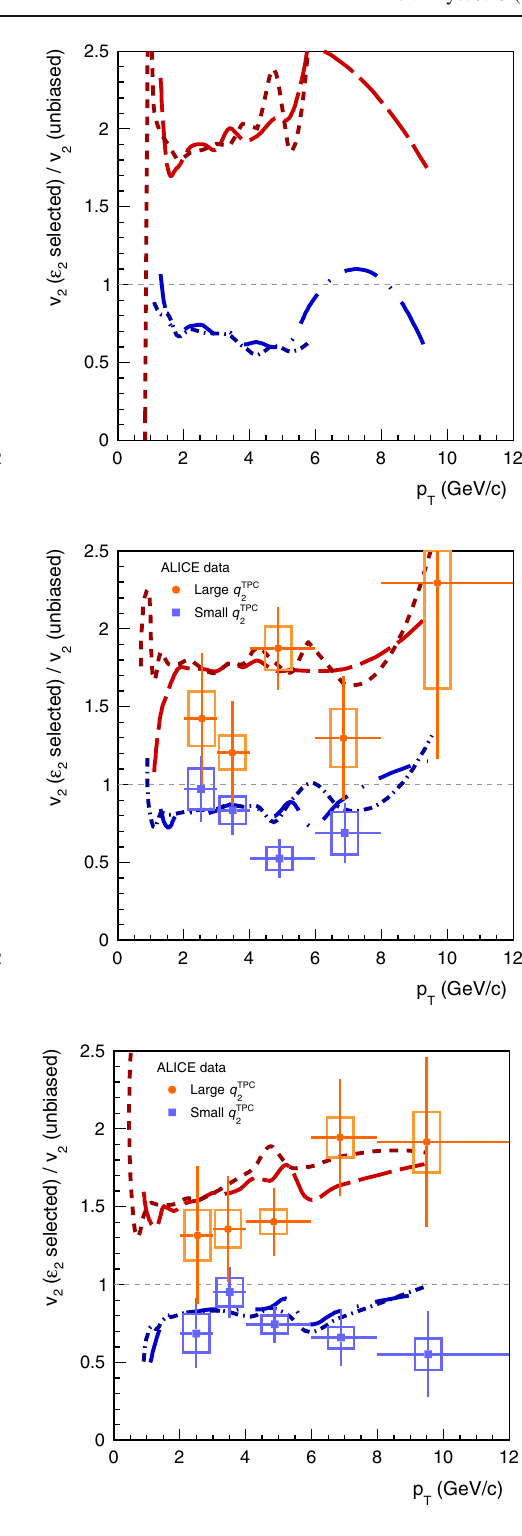
Fig. 11 The elliptic-flow coefficient v 2 of charmed hadrons in the 0– 10% (top), 10–30% (middle) and 30–50% (bottom) most central Pb–Pb √ s NN = 5 . 02 TeV. Results for the 20% highest- (cid:7) 2 and collisions at to the 60% lowest- (cid:7) 2 selection of events are compared to the unbiased